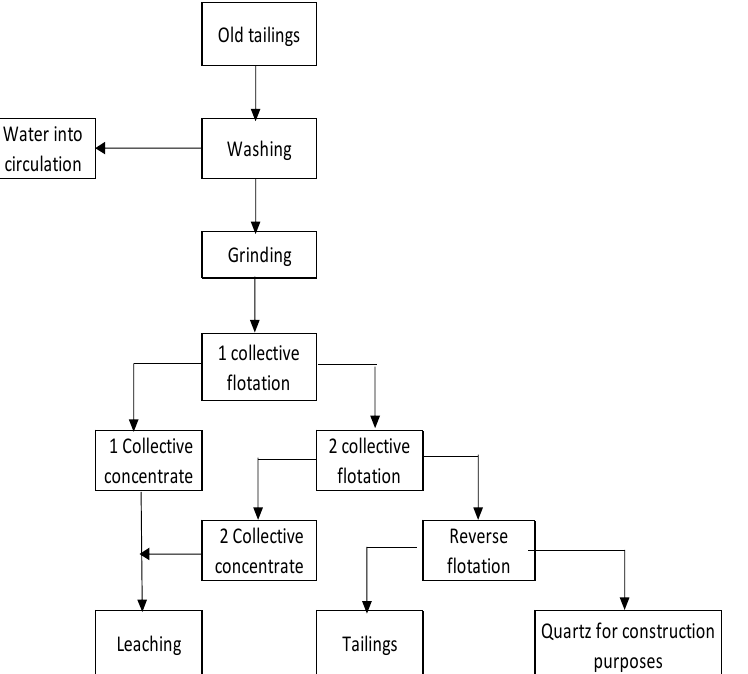
Figure 4. Recommended scheme for the processing of old tailings at the Belousovskaya Enrich- ment Plant.